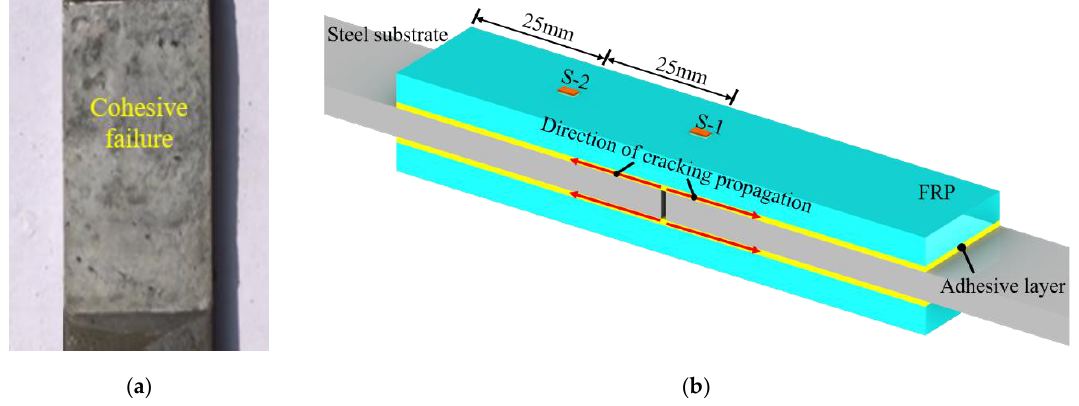
Figure 4. Failure surface and cracking propagation of the reference specimen. ( a ) Failure Surface; ( b ) Cracking Propagation.